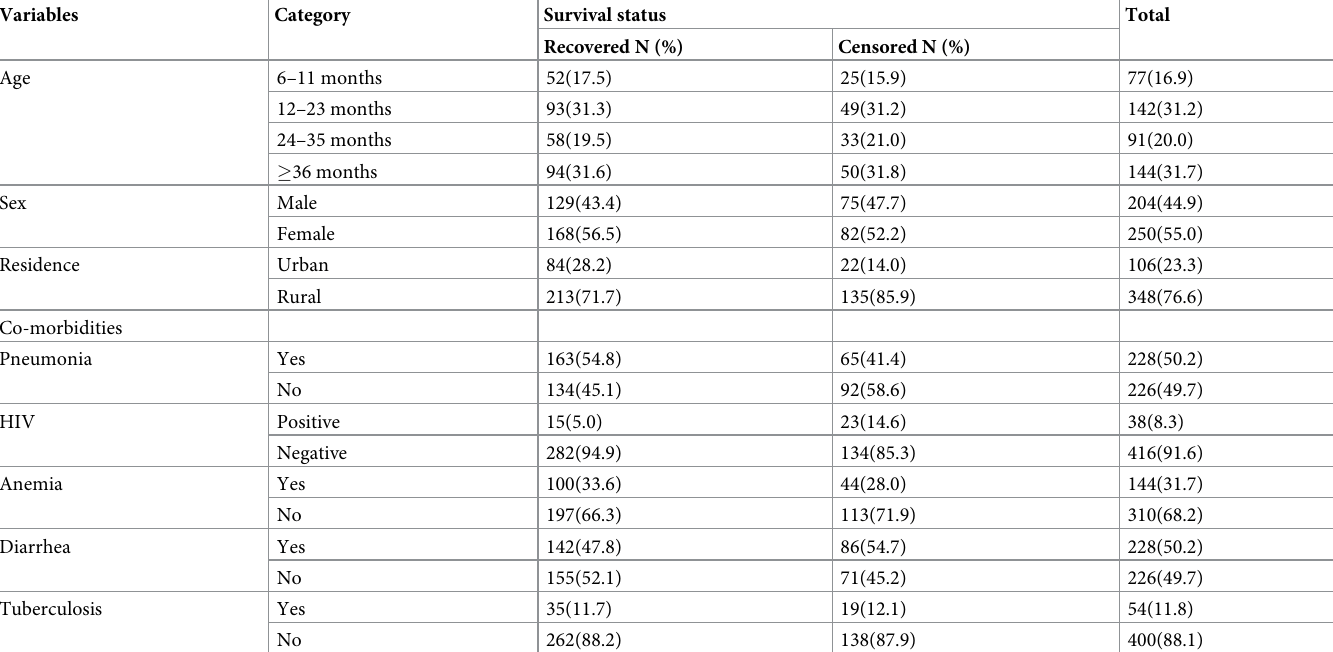
Table 1. Base-line socio-demographic characteristics and comorbidities of children admitted to Asosa general hospital,